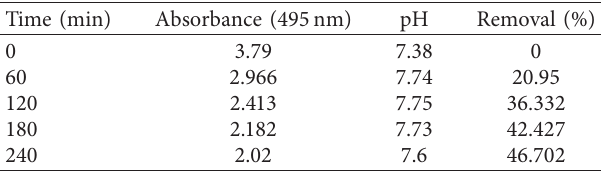
Figure 9: (a) Plot of pH with respect to time over 140min period. (b) Plot of absorbance with respect to time over 100min period. (c) Plot of percent removal with respect to time over 100min period. Table 6: Different characteristic values of collected sample treat- ment through biofilter.